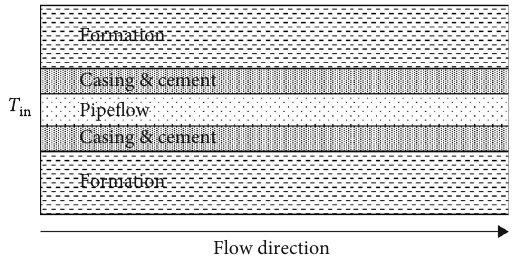
Figure 2: Structure of the horizontal segment of a